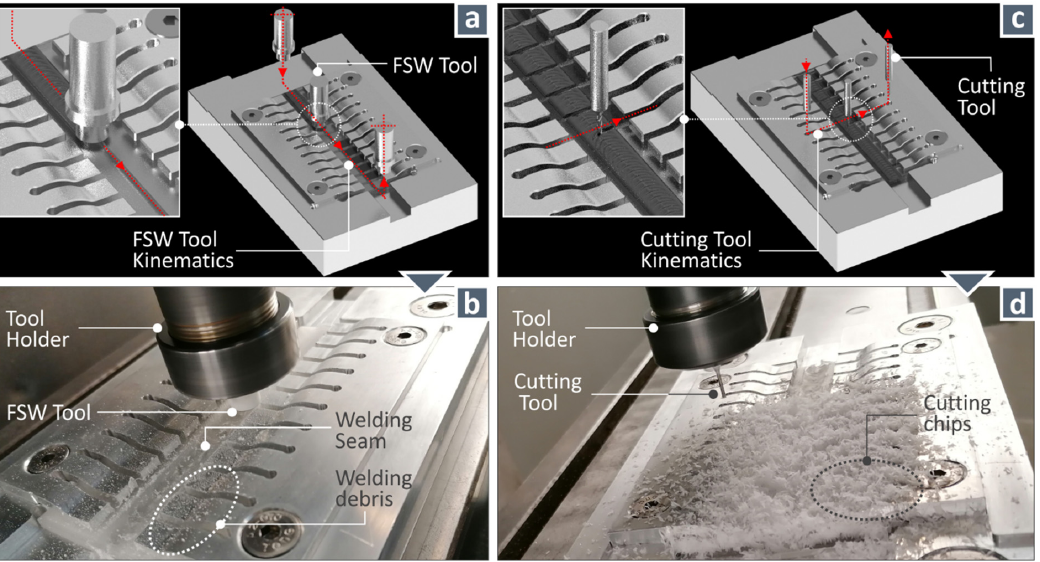
Figure 2. ( a ) FSW experimental setup; ( b ) FSW process; ( c ) sample cutting procedure; ( d ) cutting of the specimens after the FSW process.